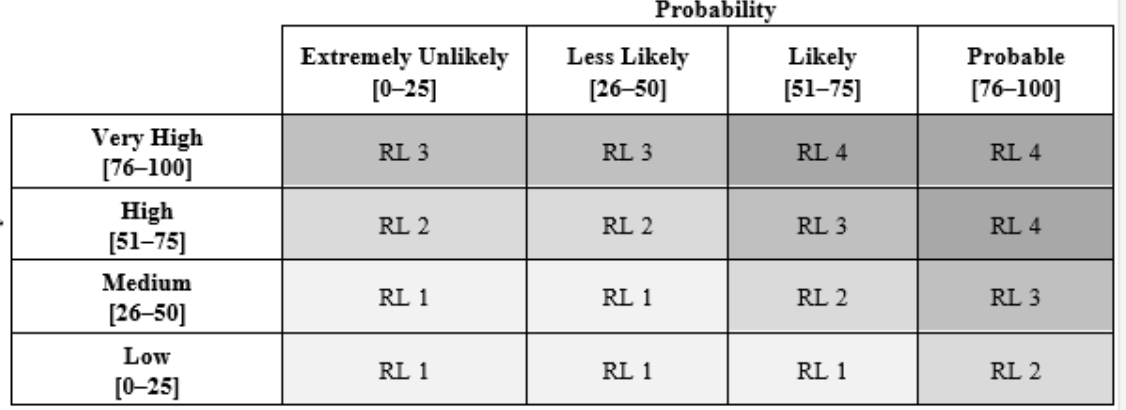
Table 1. Description of the tasks under study.